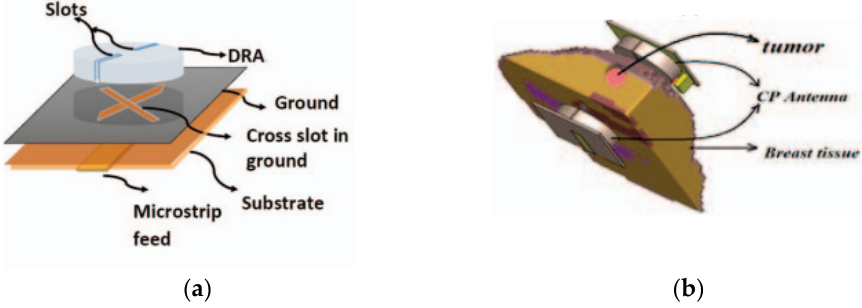
Figure 26. CP DRA: ( a ) overall configuration; ( b ) setup of the detection system [103]. Table 10. Comparison between various DRAs for biomedical applications.